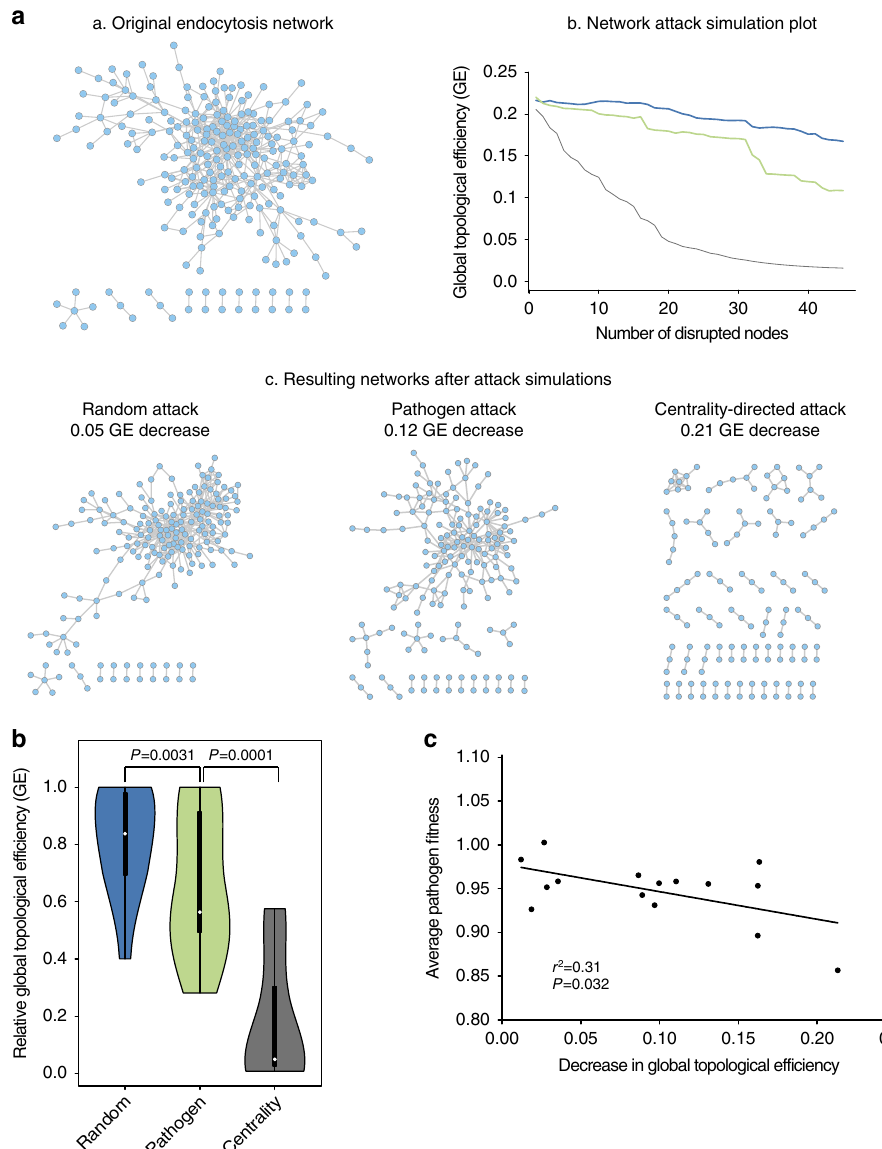
Figure 3 | Simulation of the host network attack by the pathogen Y. pestis . In a we present an exemplar of the three attack strategies used, in this case for the endocytosis pathway. The endocytosis network ( a ) was subjected to successive node removal according to a random, pathogen or centrality-based attacks ( b ). The resulting networks after each attack ( c ) are plotted for each strategy. ( b ) Global topological efficiency (GE) decrease was measured in different host networks after a random attack (blue, average of 20 simulations), a pathogen-directed attack (green) and a centrality-based attack (black). P -values were calculated using the Mann–Whitney U -test. ( c ) GE decrease was plotted against the average fitness cost of deleting the pathogen proteins involved in the